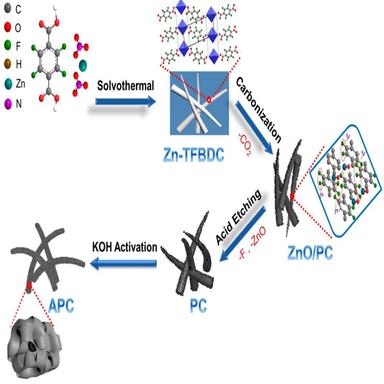
Schematic illustration of the prepared APC using Zn salt and H2TFBDC.